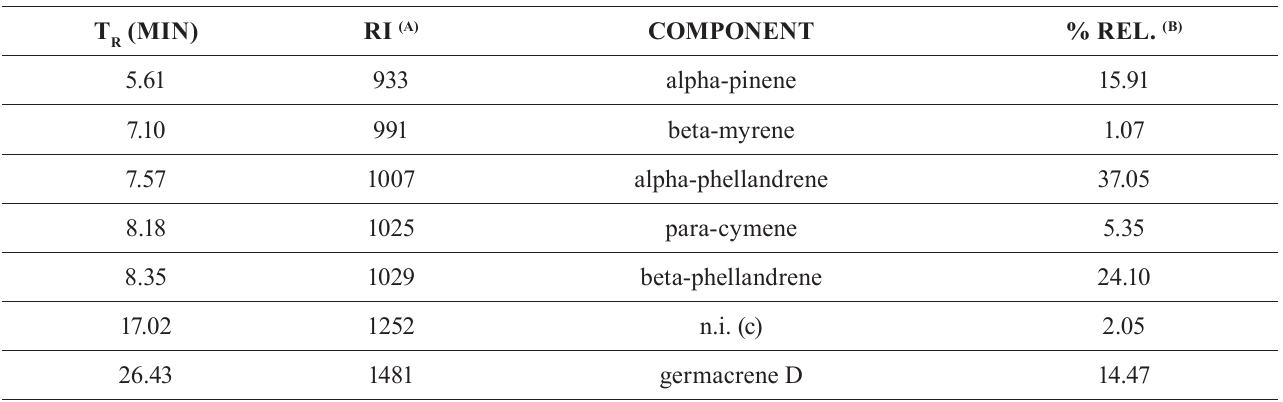
TABLE II - Analyses identified in the essential oil of S. terebinthifolia green fruits EO , by gas chromatography with mass